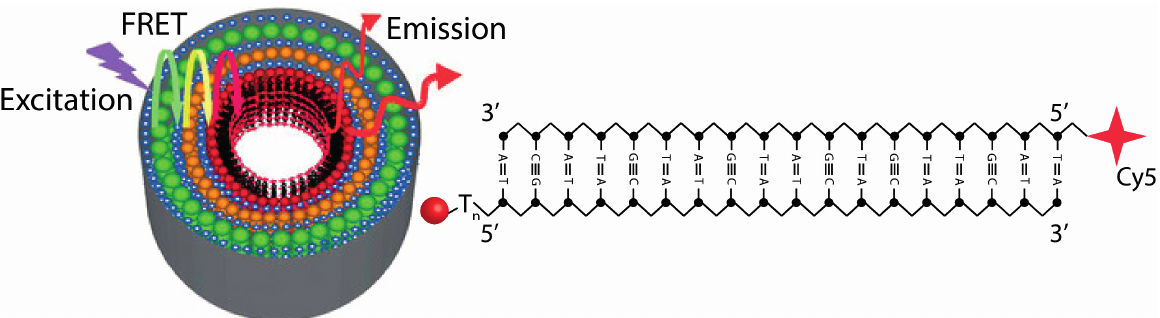
Figure 14. Schematic of the layered QD-nanotube DNA hybridization detection probe. Reprinted with permission from [123]. Schematic is not drawn to